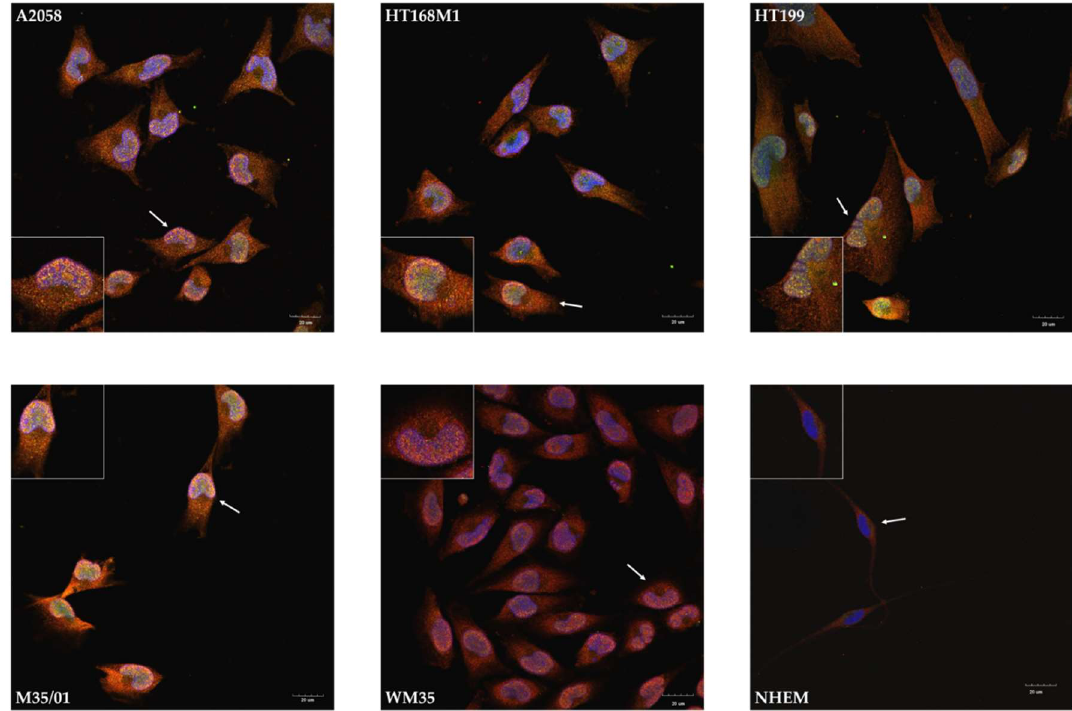
Figure 3. Immunocytochemistry demonstrating colocalization of NR1 and NR3B in the nuclei of melanoma cells, but not in the cell membrane in melanocytes. Confocal microscopic evaluation revealed that NR1 (red) was present in the cytosol of every melanoma cell line, while NR3B (green) showed weaker and less diffuse signals in the cytoplasm. Unambiguous plasma membrane immunofluorescent signals were not visible, but NR1 and NR3B colocalized inside the nuclei of melanoma cells. NR1 and NR3B colocalization was absent or undetected in the nuclei of NHEM. That 1-μm thick optical section was selected for presentation which specifically went through the majority of nuclei to show that all nuclei were immunopositive. One representative cell pointed by white arrow was selected for the inserts at each part of the panel. Scale bar: 20 μm. Positive controls for the secondary antibodies and special controls for the primary antibodies were also performed (see Supplementary Information Figure S8A,B).